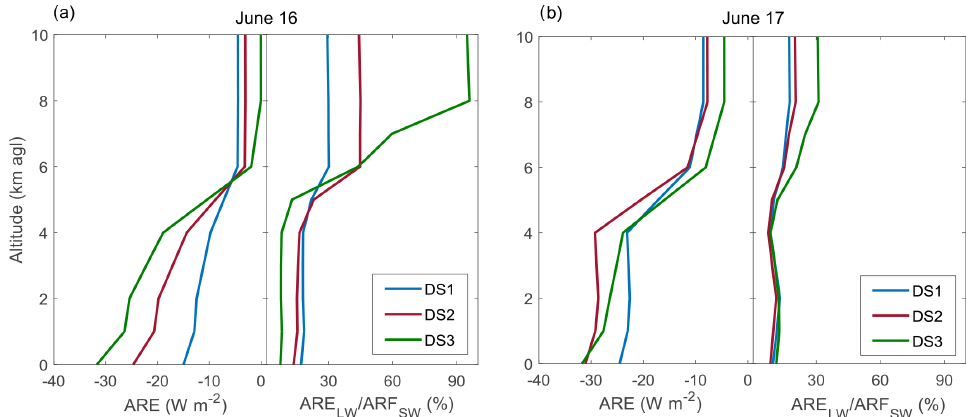
Figure 12. Direct ARE for the total spectrum (a) and the ratio between the ARE LW and the ARE SW in percentage for DS1 (blue), DS2 (red), and DS3 (green) on 16 June at 14:30UTC (a) and 17 June at 07:30UTC (b)